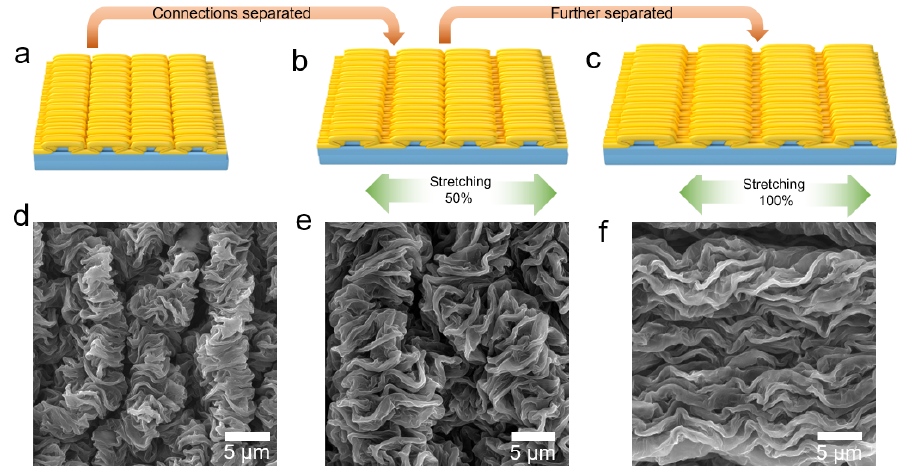
Figure 10. Diagrams of the stretching at ( a ) initial, ( b ) 50% strain, ( c ) 100% strain; SEM images of the stretching at ( d ) initial, ( e ) 50% strain, ( f ) 100% strain.